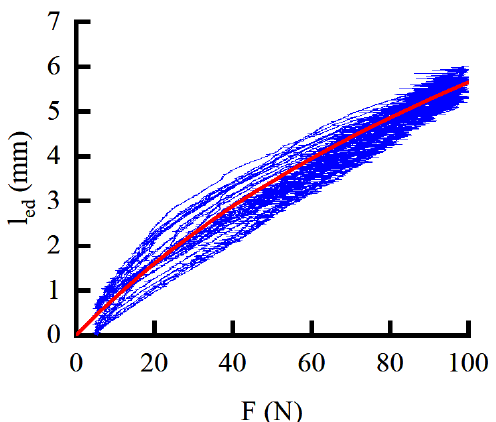
Figure 6. The relationship between the displacement and the interaction force.